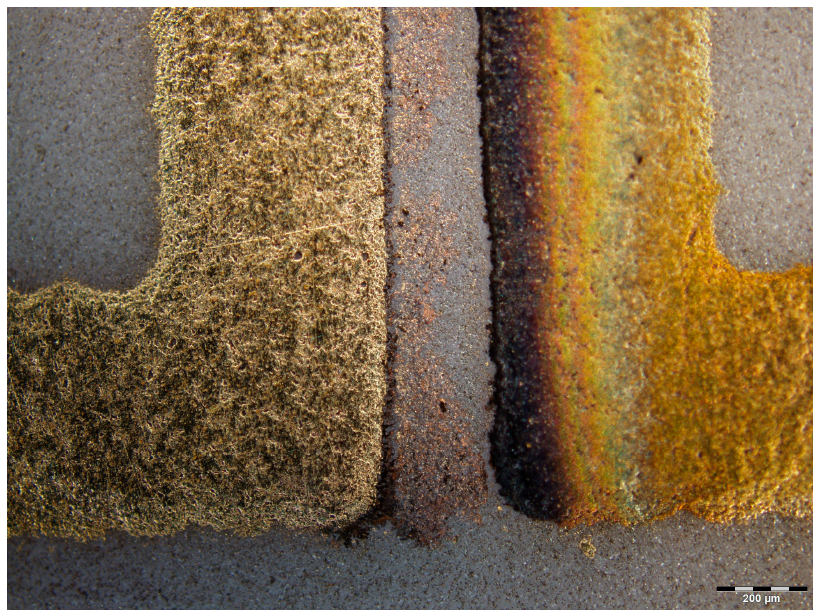
Figure 3. Gold deposits and dendrites on the samples after WD tests performed with 5 V bias.